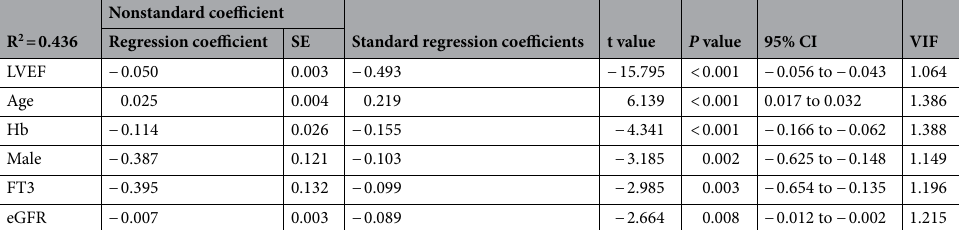
Table 5. Results of the multiple regression analysis to identify the clinical factors influencing log BNP (n = 625). BNP, B-type natriuretic peptide; R 2 , adjusted coefficient of determination; CI, confidence interval; VIF, variance inflation factor; LVEF, left ventricular ejection fraction; Hb, hemoglobin; FT3, free triiodothyronine; eGFR, estimated glomerular filtration rate.